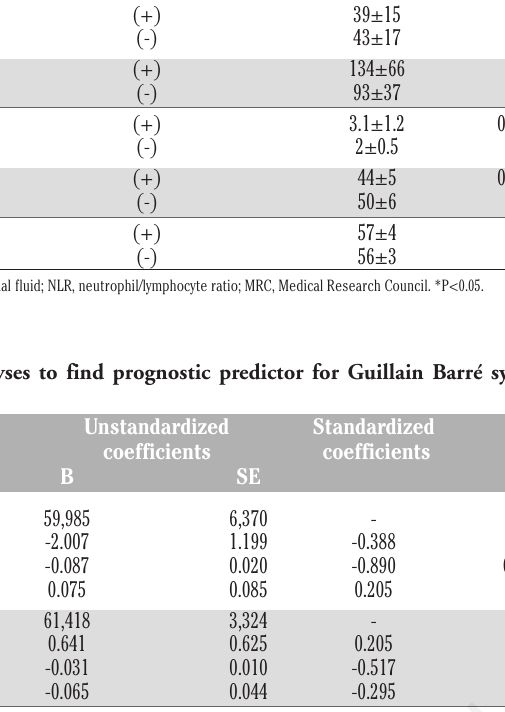
Table 2. The comparative analyses of facial diplegia (+) and (-) group. Facial diplegia (+)/(-)